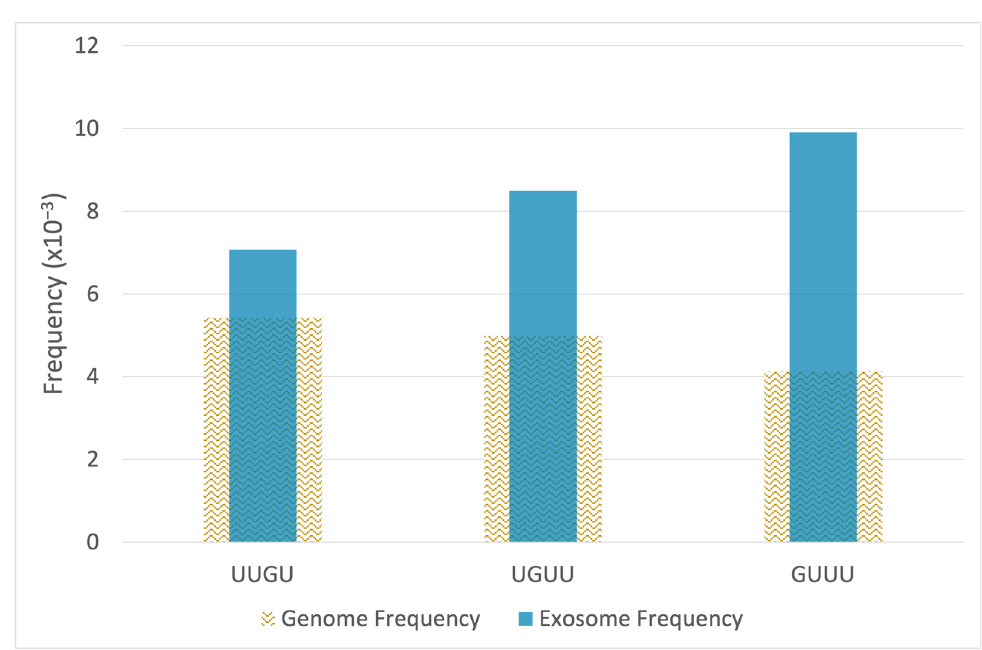
Figure 2. Exosomes isolated from epileptogenic tissue are enriched with microRNAs having G/U-rich motifs that activate TLR7/8. The sequences of 37 microRNAs increased in the cargo of epileptogenic exosomes were analyzed for nucleic acid motifs that function as ligands and activators of TLR7/8. The frequency of TLR7/8 motifs is significantly higher in the set of 37 exosomal microRNAs compared to the overall set of human microRNAs ( p = 0.017, hypergeometric test).